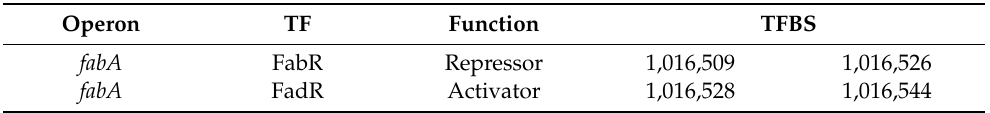
Table 1. Transcription regulation of the fabA E. coli operon from RegulonDB where TFBSs mark the absolute positions of binding sites in a genome.